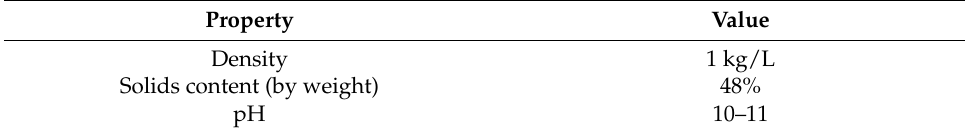
Table 2. Characteristics of SBR latex.